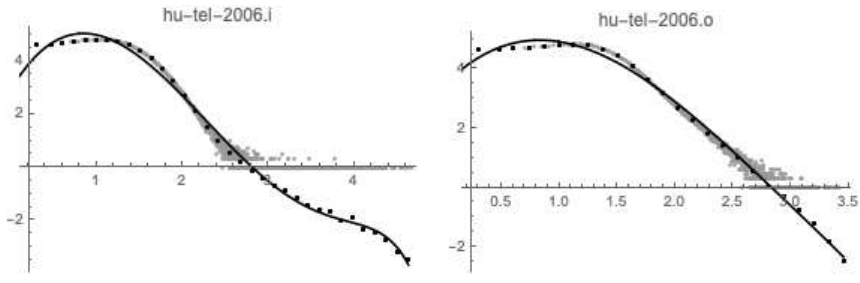
Figure 7. Log-log solutions of hutel2006.i ( on the left ) and of hutel2006.o ( on the right ). Most of the considered graphs are rating networks between persons and items they have rated. The ratings values are ignored, and only the information whether a person has rated an item is retained.